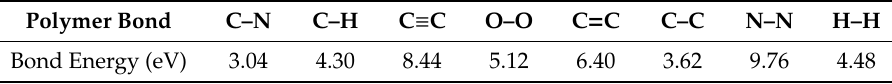
Table 2. Chemical bond energies for